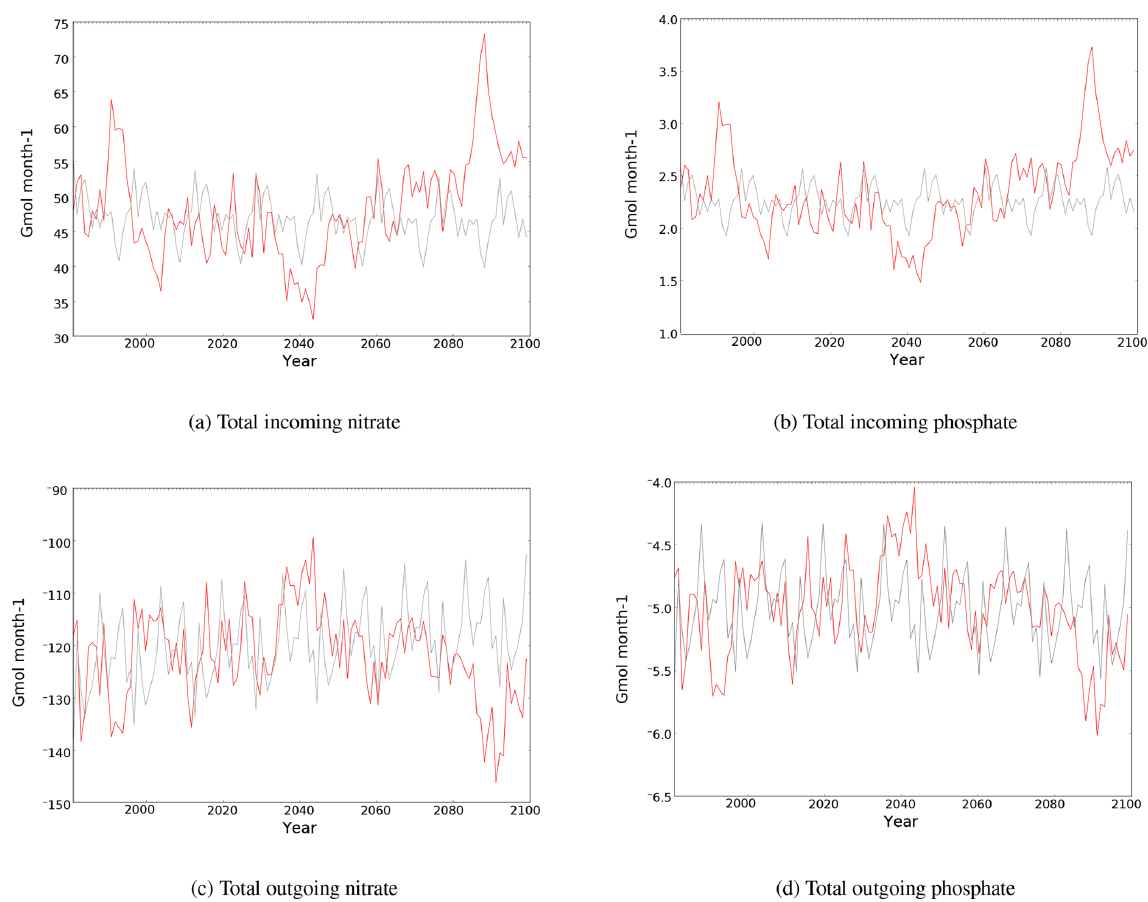
Figure 4. Evolution of total incoming (a) and outgoing (b) fluxes of nitrate and phosphate (10 9 molmonth − 1 ) through the Strait of Gibraltar in the CTRL (grey) and HIS/A2 (red) simulations. Negative values indicate outgoing fluxes of